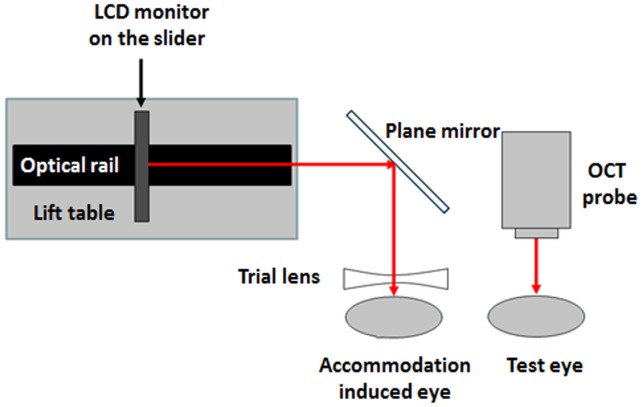
Diagram of the fixation target system.A 1.2 m long optical rail was installed upon a lift table, and placed beside the slit lamp, fixed by a Philips 17-inch LCD monitor on a slider for displaying the target. This LCD monitor was able to move along the optical rail to adjust the distance between the visual target and the human eye, to induce a different stimulus of accommodation. In order to allow the subjects to fix on the target, without being affected by the moving probe, a plane mirror was installed on the slit lamp column, so that the target was projected into the eye after specular reflection.